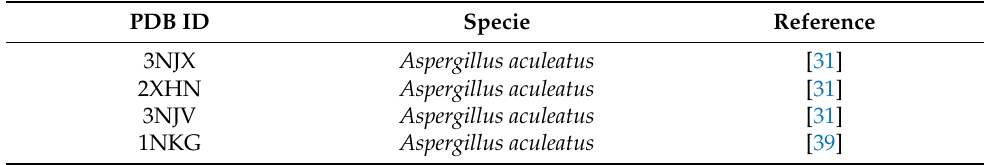
Table 1. Crystallographic structures of RGL belonging to the PL4 group, deposited in the Protein Data Bank. PDB